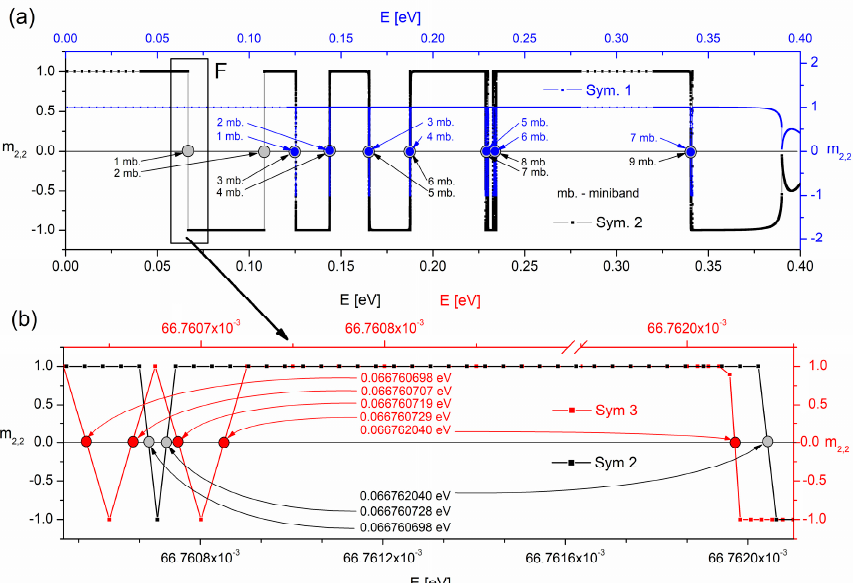
Figure 7. Graphs of the m 2,2 ( E ) function obtained in the simulation of the structure reported in [28]: ( a ) for 4 periods (Sym. 1) and 5 periods (Sym. 2–3) of the superlattice, with BM (Sym. 1) and MBM (Sym. 2–3) applied, with the interval dE = 1 − 6 eV; ( b ) calculation results of the m 2,2 ( E ) function